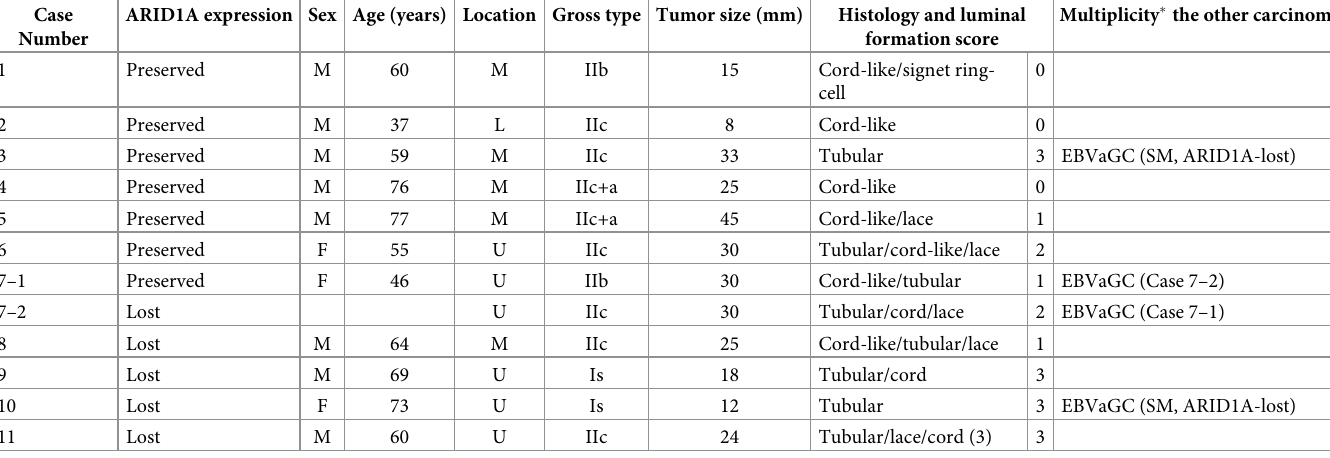
Table 2. Clinicopathological characteristics of intramucosal EBVaGC with preserved or lost ARID1A. ARID1A expression Sex Age (years) Location Gross type Tumor size